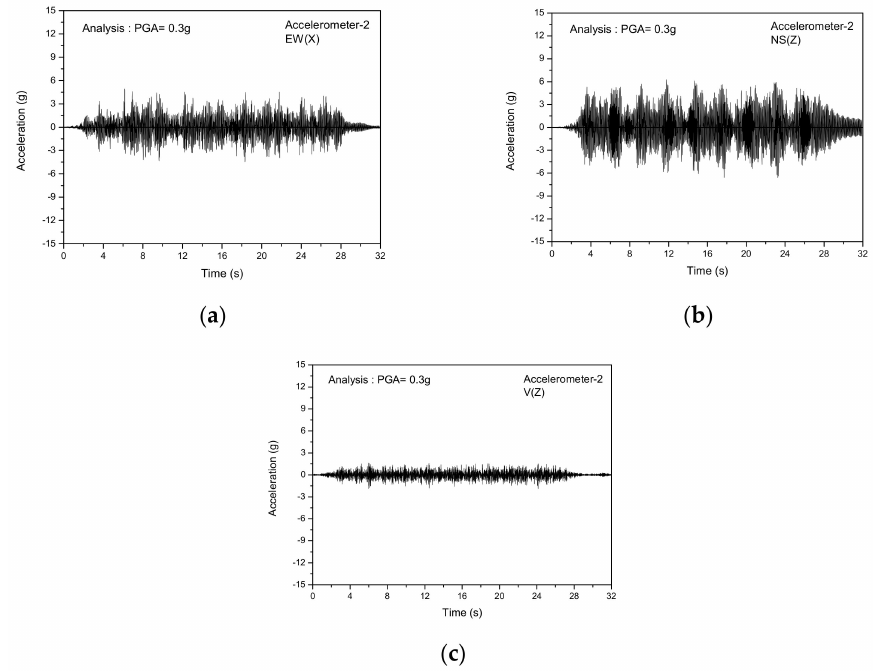
Figure 21. Inelastic seismic analysis results of acceleration responses at Accelerometer-2 for PGA = 0.3 g: ( a ) EW (X); ( b ) NS (Z); ( c ) V (Y).